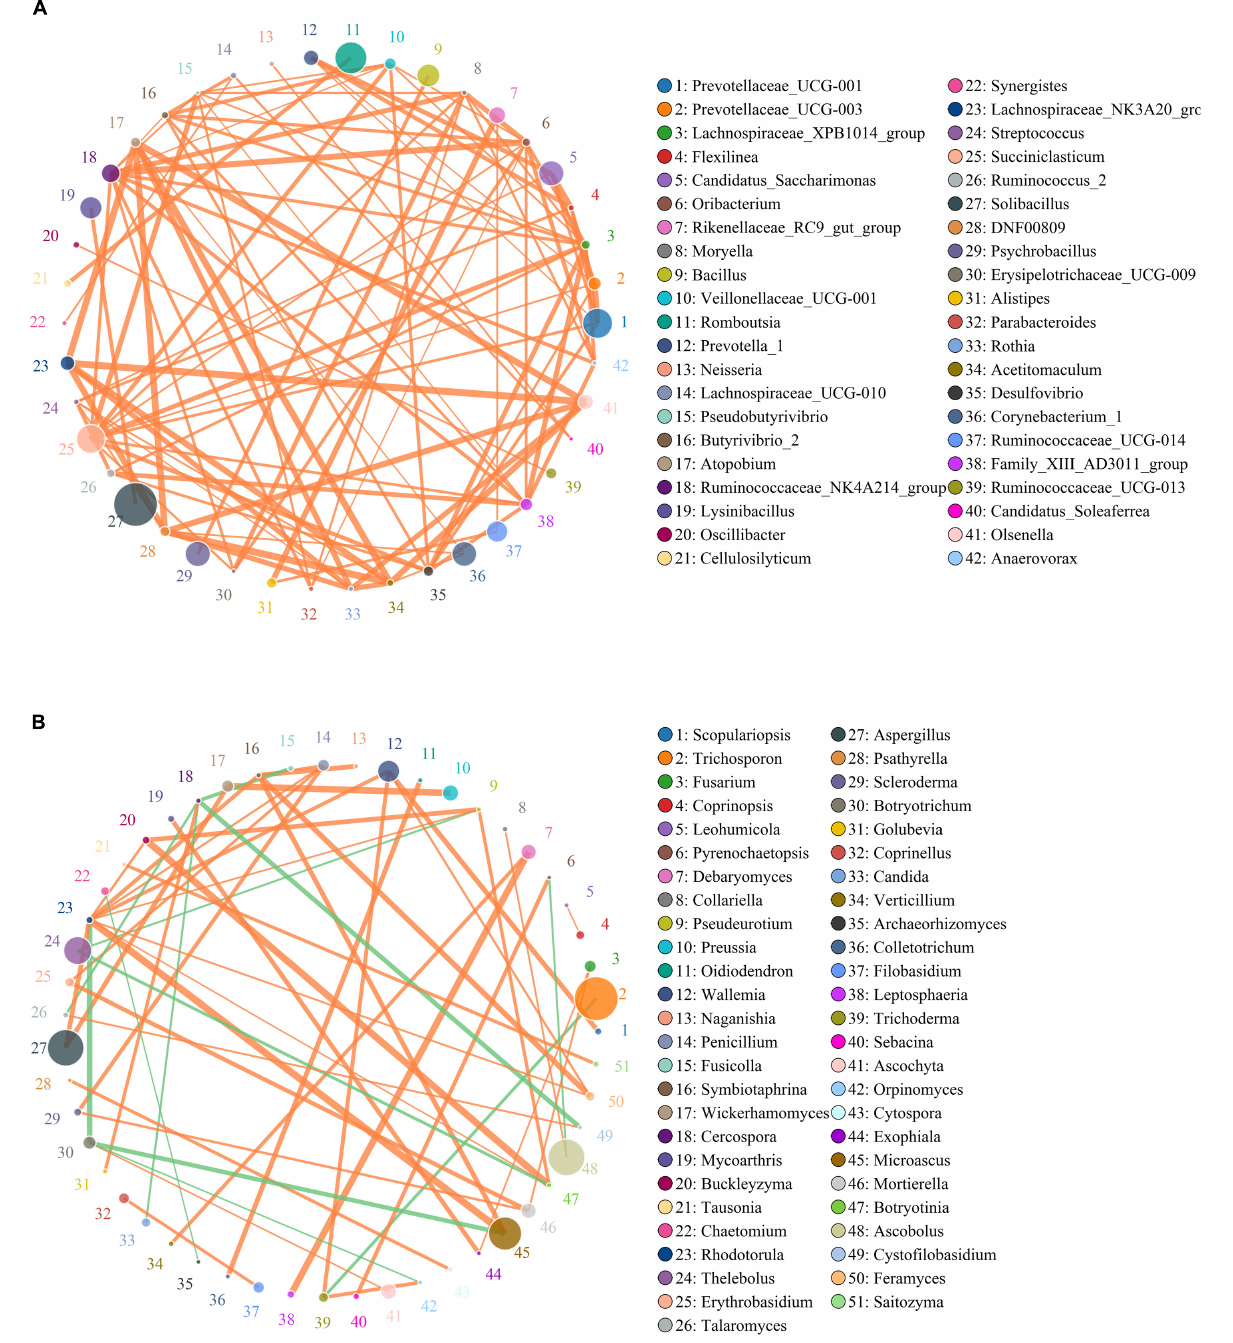
FIGURE 7 | Correlation network reveals the correlation among the different bacterial (A) and fungal (B) genera. The circles with different colors indicate the name of bacterial and fungal genus, and their sizes represent relative abundance. The strength of the correlation between both genera is positively related to the thickness of the line. The green line between both genera represents a positive correlation, whereas the orange line indicates a negative